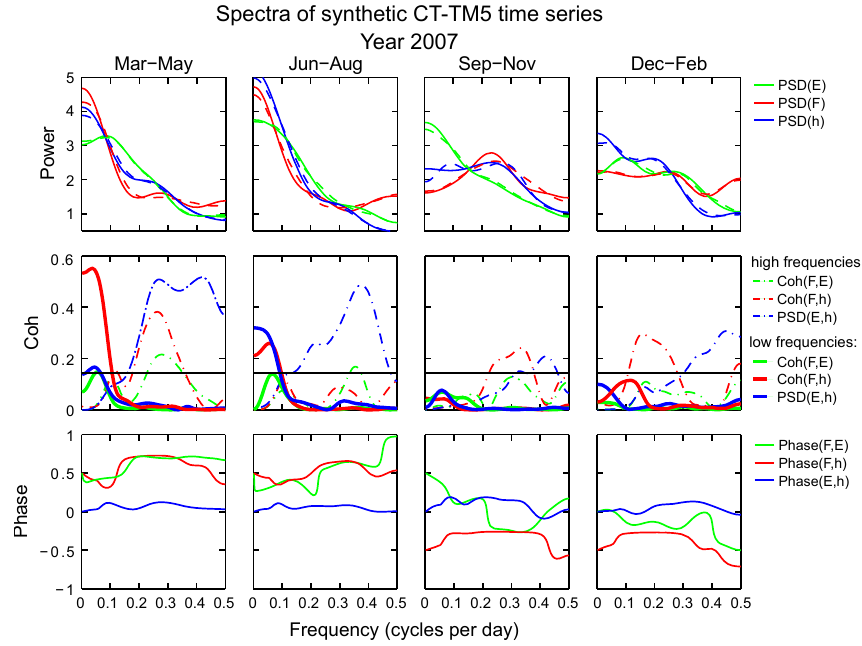
Fig. 7. Top row: power spectral densities of E (green), F (red), and h (blue), estimated from CT-TM5 forcing time series for year 2007, normalized in order to have equal area under each curve. Middle row: coherence spectra corresponding to the cross-spectral densities CSD F,E (green), CSD F,h (red), and CSD E,h (blue), separated into contributions from low frequencies (thick lines) and high frequencies (dashed- dotted lines), with a separation timescale of 10 days (0.1 cycles per day). Bottom row: phase spectra corresponding to the cross-spectral densities CSD F,E (green), CSD F,h (red), and CSD E,h (blue). The horizontal black line (middle row) indicates the 90% confidence level for